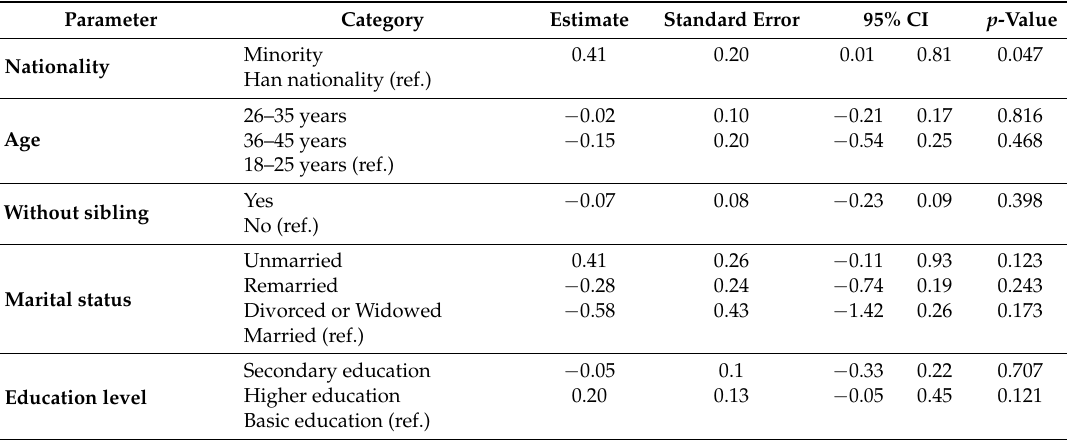
Table 4. Ordered multivariate logistic regression for poor quality of sleep among pregnant women in